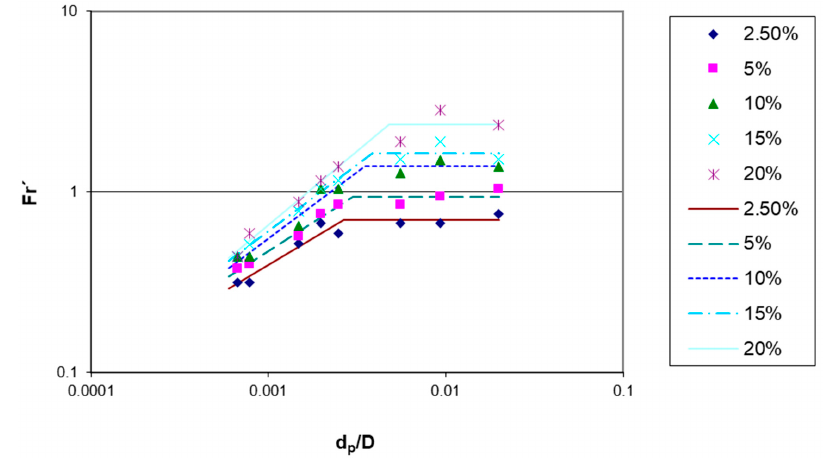
Figure 1. Dependence of Fr’ on relative particle size d p / D and mean volumetric concentration of particles c, presented in [8] (points—experimental results, line—regression according to Equation (2) by least-squares regression analysis).